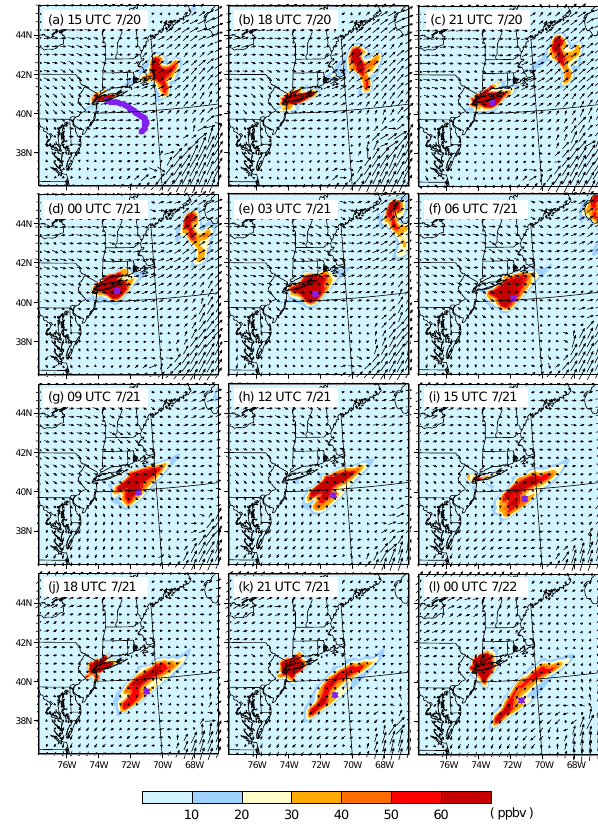
Fig. 10. Horizontal distributions of simulated CO NYC mixing ra- tios and horizontal wind fields in the lower-level NYC plume layer from 15:00 UTC on 20 July to 00:00 UTC on 22 July with 3-h intervals. The plotted CO NYC mixing ratios are the difference be- tween the simulation with doubled CO emissions for the New York City area and the control simulation, and vertically averaged from ∼ 140m to ∼ 600 m. The full forward trajectory of an urban CO NYC plume originated from New York City from 18:00 UTC on 20 July to 00:00 UTC on 22 July is shown in (a) , and the location of the plume tracked is depicted by asterisk marks in (c–l) .